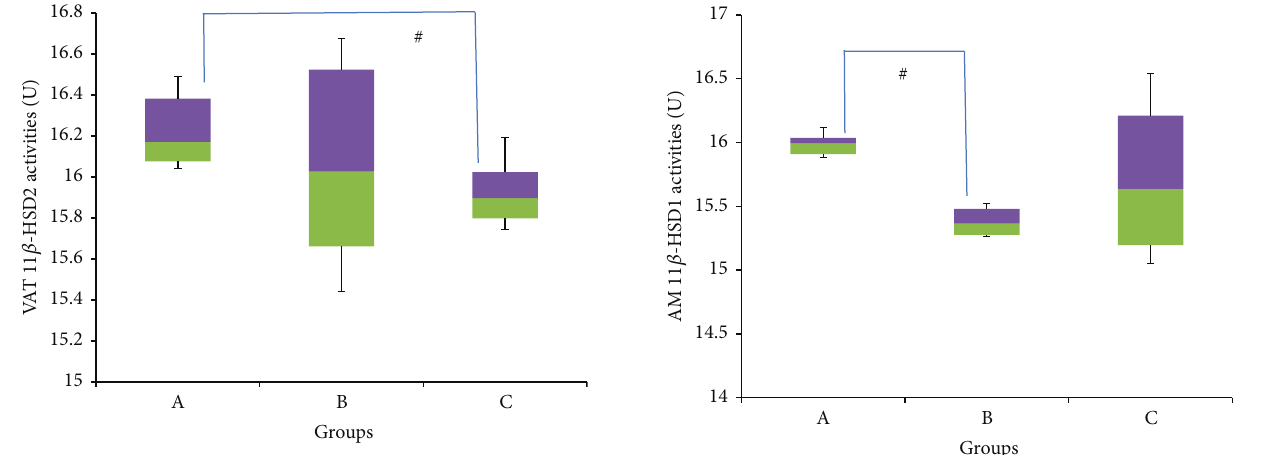
Figure 16: 11 𝛽 -HSD 1 activities in abdominal muscle of rats in group A, B, and C at the end of the four-week treatment period. # Significant difference ( 𝑃 < 0.05 ) between denoted groups. Group A: control (HSD/HFD); group B: stress + HSD/HFD; group C: stress + GA + HSD/HFD. Abbreviations: GA: glycyrrhizic acid, HSD: high-sucrose diet, and HFD: high-fat